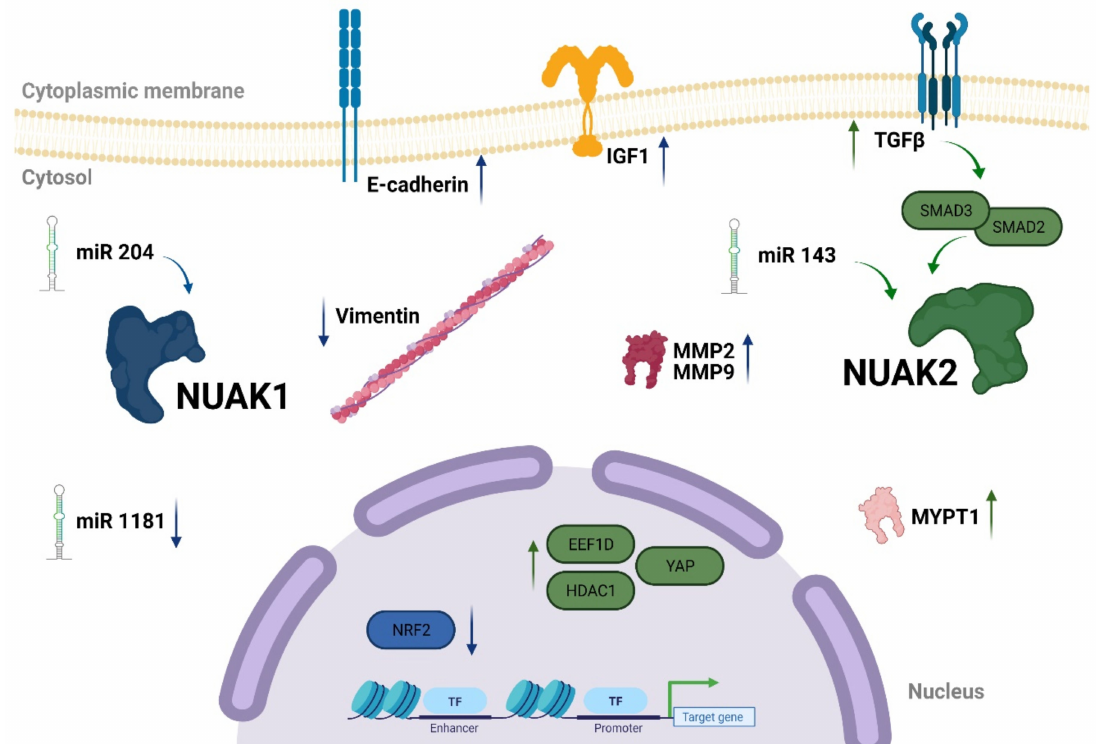
Figure 4. Schematic representation of NUAK1 and NUAK2 upstream and downstream targets. NUAK1/2 downstream targets are indicated with blue arrows (NUAK1) and green arrows (NUAK2). The direction of the arrow indicates whether the regulation of NUAK1/2 is direct (up arrow) or inverse (down arrow). Depicted in the cytoplasmic membrane are different protein receptors. Cytoskeleton proteins as well as cytoplasmic proteins and micro RNAs are represented in the cytosol. Proteins with square icons represent transcription factors. NUAK1 downstream targets involve different members of adhesion and cytoskeleton proteins such as vimentin and E-cadherin which share a similar role in invasion and metastasis. NUAK2 regulates different transcription factors related to pro-inflammatory cytokines which in turn activate the TGF- β signaling pathway ending a positive feedback loop. Conversely, NUAK1 protein negatively regulates TGF- β downstream signaling targets. Figure created in